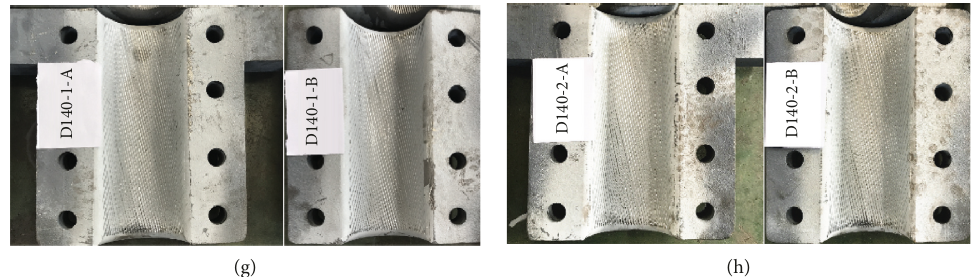
Figure 14: Clamp grooves after antisliding failure. (a)